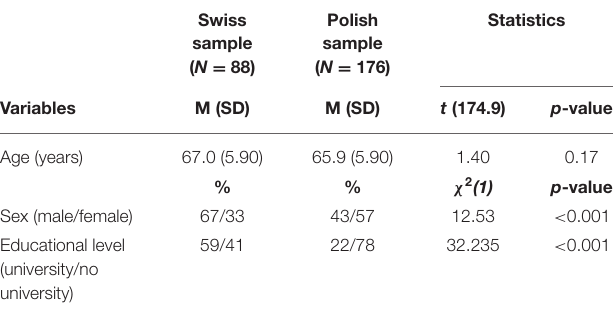
TABLE 1 | Demographical